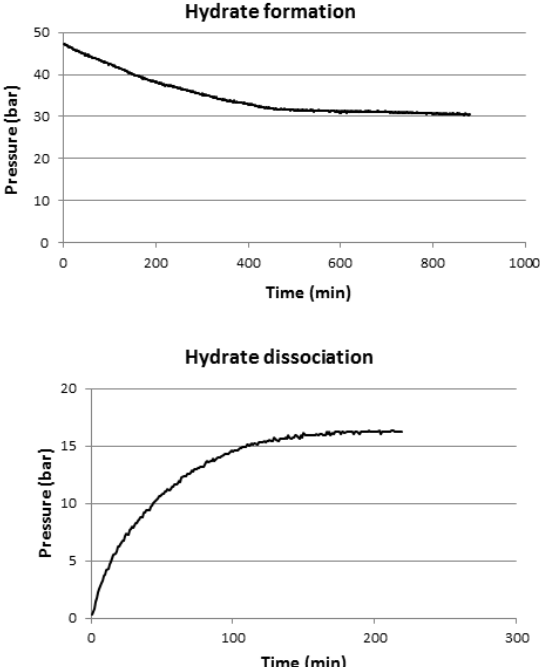
Figure 7. Pressure trend in Test 1.